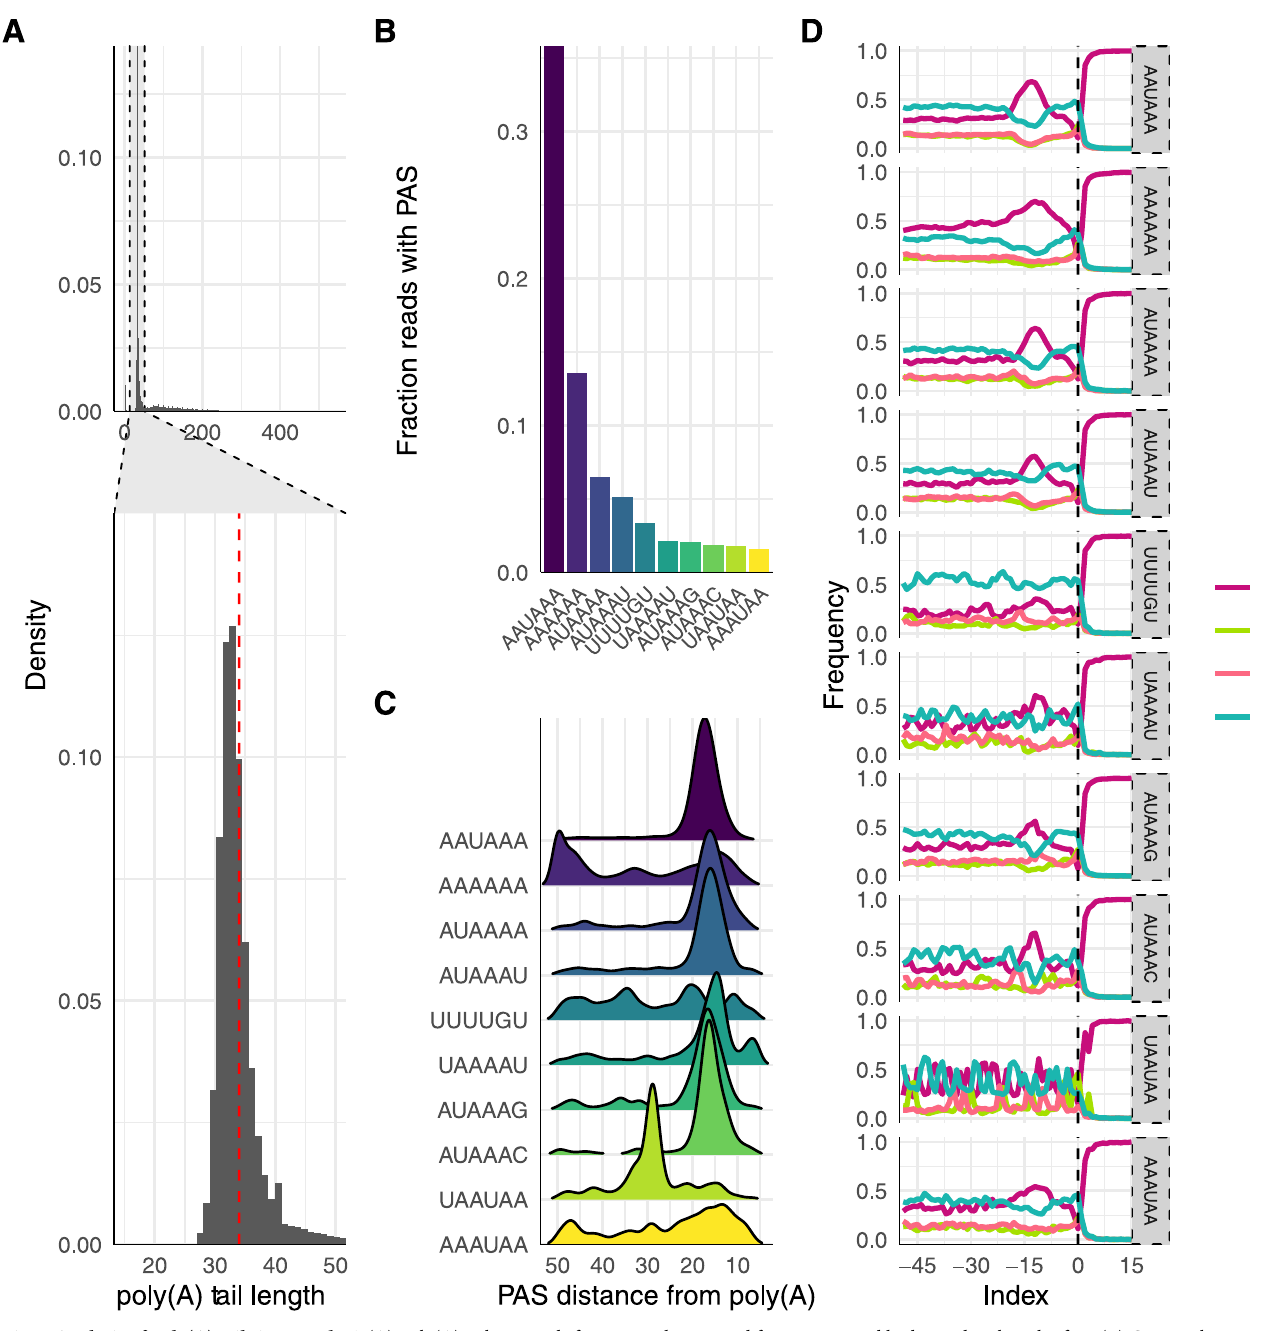
Fig 6. Analysis of poly(A) tails in B . malayi . (A) Poly(A) tails on reads from B . malayi ranged from 0–541 and had a median length of 33. (B) Greater than 35% of reads contained the canonical poly(A) signal (PAS) AAUAA, while A-rich regions were the second most abundant PAS. (C) All PASs occur 10–20 nucleotides upstream of the poly(A) cleavage site, other than AAAAA, which has two A-rich sites at 10–20 and 45–50 nucleotides upstream, and UAAUAA, which may not be a PAS but is a motif for RNA binding proteins [64,65]. (D) All PASs also include an A-rich region at 15 nucleotides upstream of the cleavage